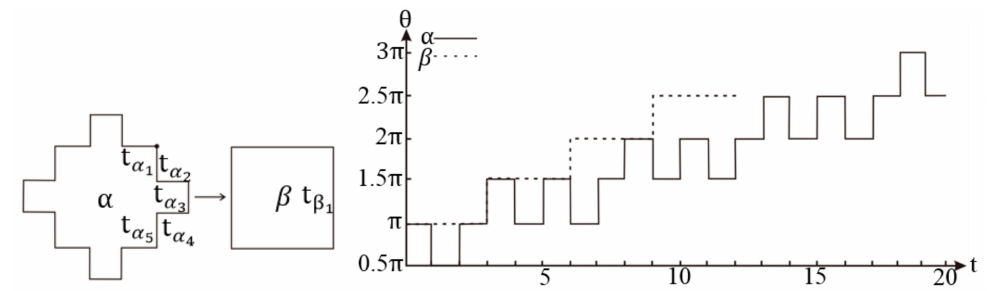
Figure 2. Overlap of the frequency curves of shapes α and β in different domains.